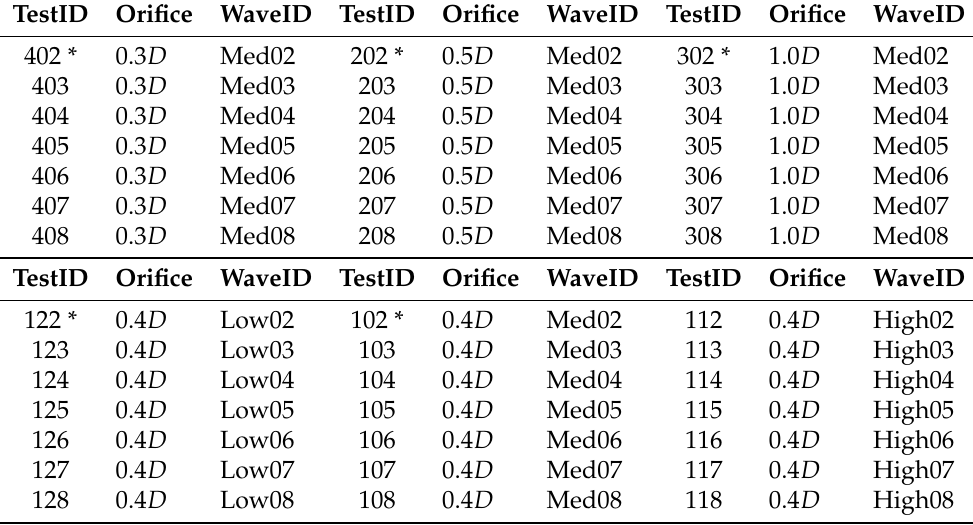
Table 2. The experimental wave conditions. The cases marked by * indicate that the chamber elevations were too small to allow for synchronization of the